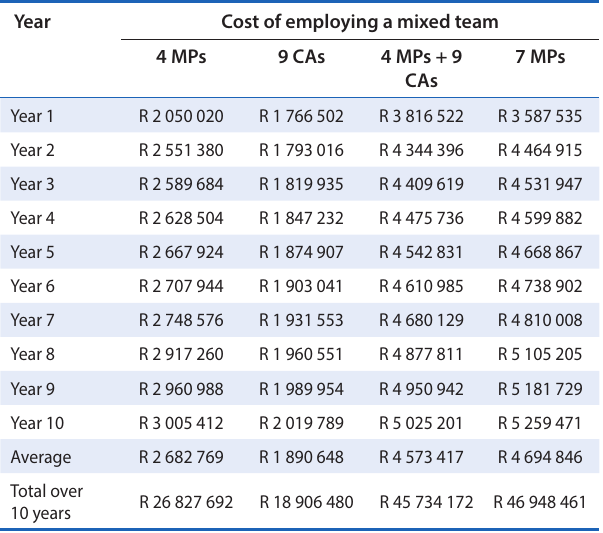
Notes: MPs = Medical Practitioners; CAs = Clinical Associates.